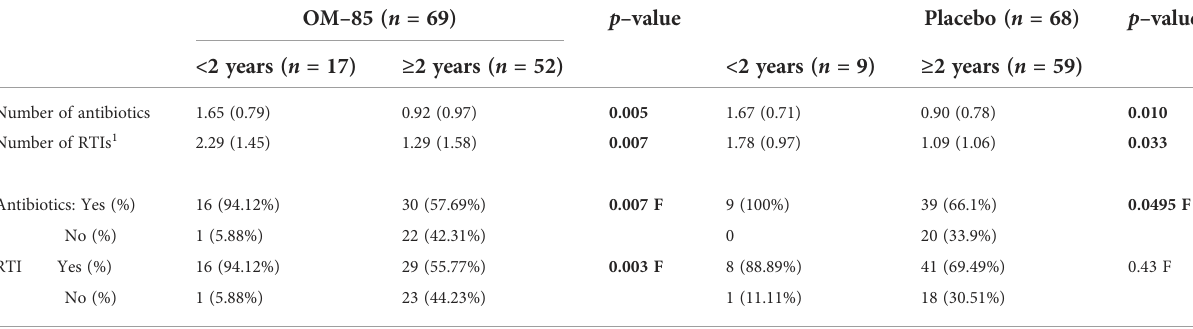
TABLE 4 Mean (SD) number of antibiotic prescriptions and respiratory infections, use of antibiotics (yes, no), and RTI occurrence (yes, no) in subgroups of children <2 years or ≥ 2 years during the study in the OM – 85 and the placebo groups. . OM – 85 ( n = 69) p – value Placebo ( n =